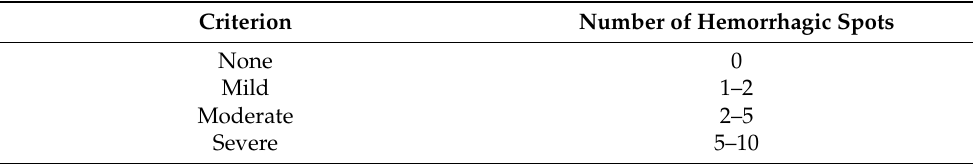
Table 4. Criteria for Jejunal Gross Lesions in the Broiler Chicken DSS-Induced Enteritis Model.